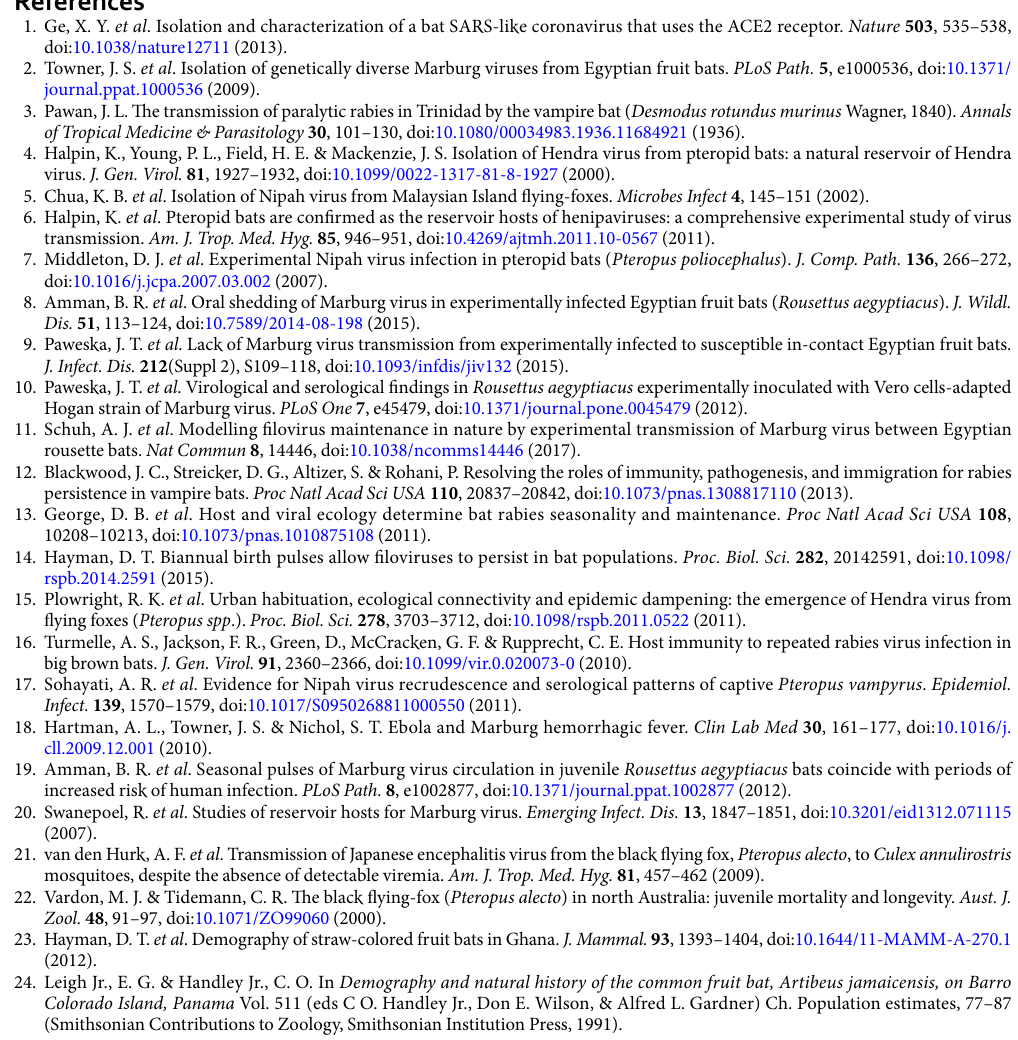
Figure 1 was created using GraphPad Prism 7.01 (GraphPad Software, La Jolla, CA, USA). Repeated measures ANOVA analyses were performed to determine if MARV IgG antibody levels differed significantly (two-tailed P < 0.05) between: 1) study group (group 1 = 5 bats; group 2 = 5 bats) over time and 2) sex (females = 5 bats; males = 5 bats) over time (SPSS Statistics 21, IBM Software, Armonk, NY, USA). Shapiro-Wilk tests (two-tailed P ≥ 0.05) concluded that the assumption of normality had been met for both data- sets by verifying that MARV IgG levels were normally distributed at each level of: 1) study group and time, and 2) sex and time. Mauchly’s tests indicated that the assumption of sphericity had been violated for both datasets (1: χ 2 = 12.479, d.f. = 5, two-tailed P = 0.030; 2: χ 2 = 13.309, d.f. = 5, two-tailed P = 0.022), therefore degrees